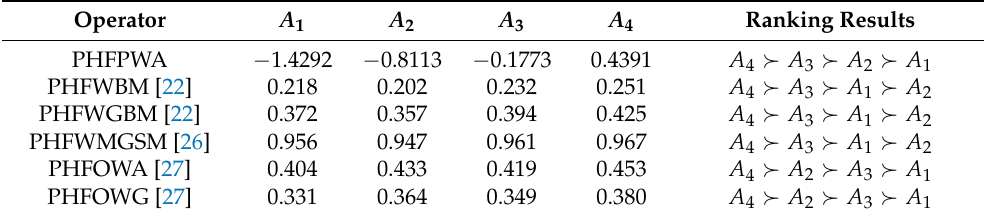
Table 8. The combined score and sorting results obtained by using different